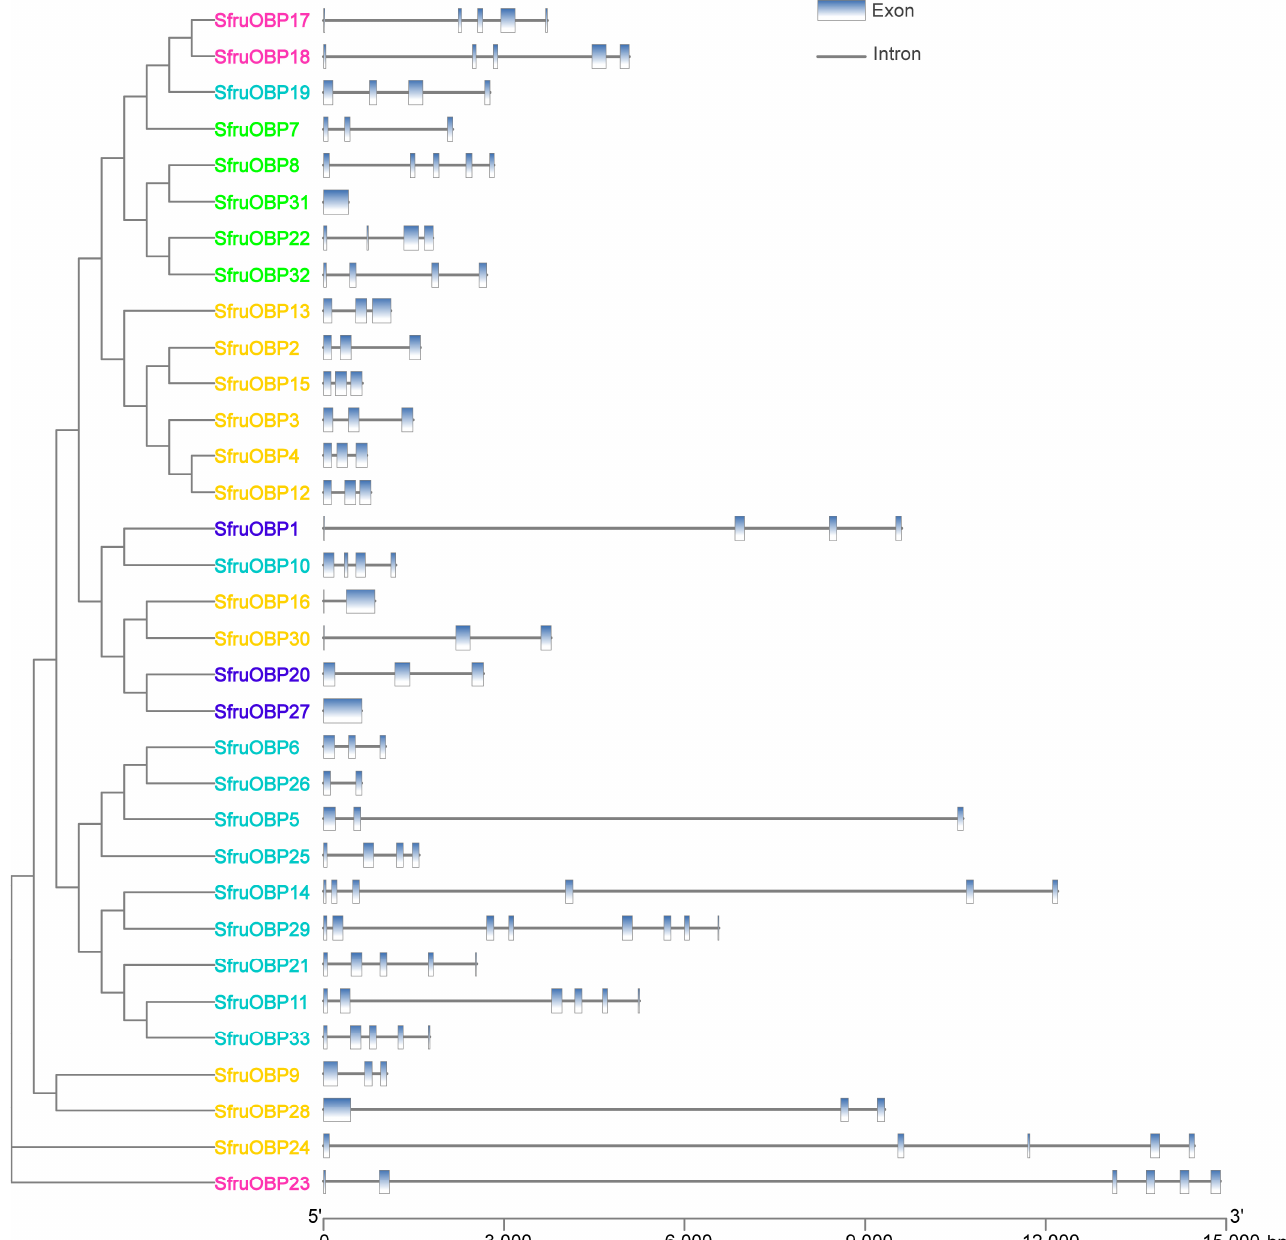
Figure 5. Exon–intron structures of SfruOBP genes. The blue boxes represent exons and the black lines indicate introns. The x ‐ axis below scales the nucleotide sequence length (bp) of the gene. The full ‐ length intron/exon composition of each gene is reported in Table 1. Different colors of the gene names indicate OBPs from specific Clusters as indicated in Figure 1: cyan, Cluster 1; pink, Cluster 2; bright green, Cluster 3; blue, Cluster 4; orange, Cluster 5.